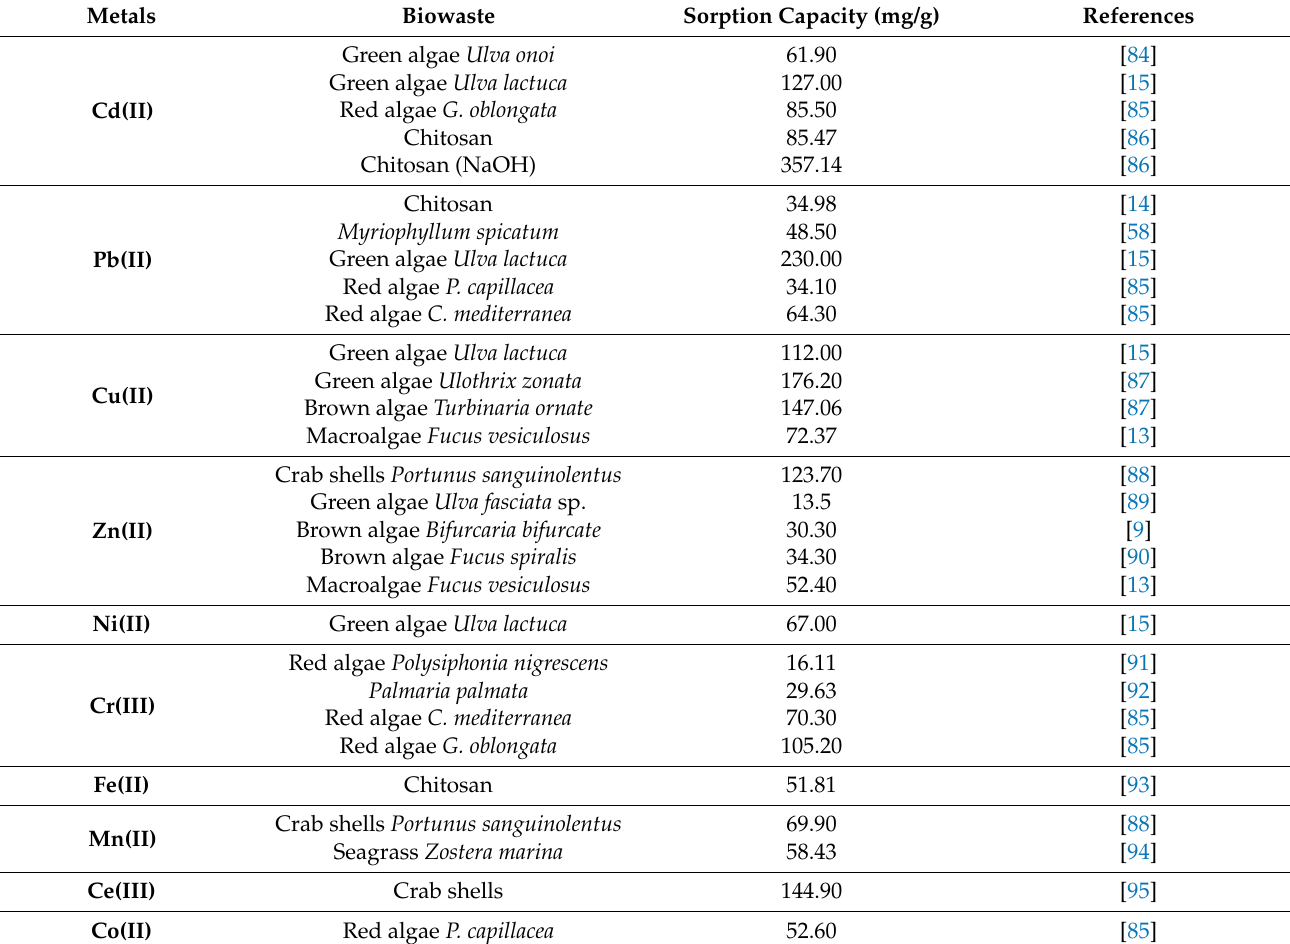
Table 3. Biowaste from fisheries used to remove heavy metals from